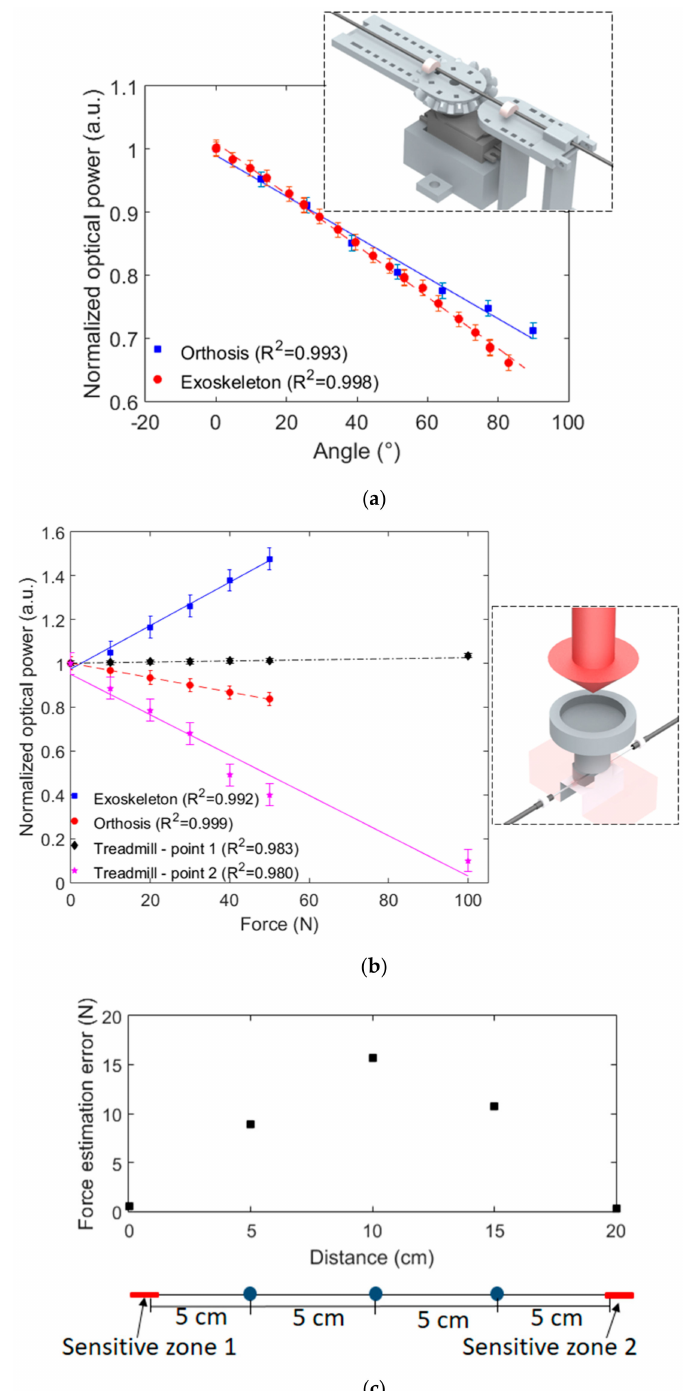
Figure 3. POF sensor characterization as a function of the ( a ) angle and ( b ) force. The figure insets show a schematic representation of the devices used in the characterization. ( c ) Error in the force estimation as a function of the weight placement on the